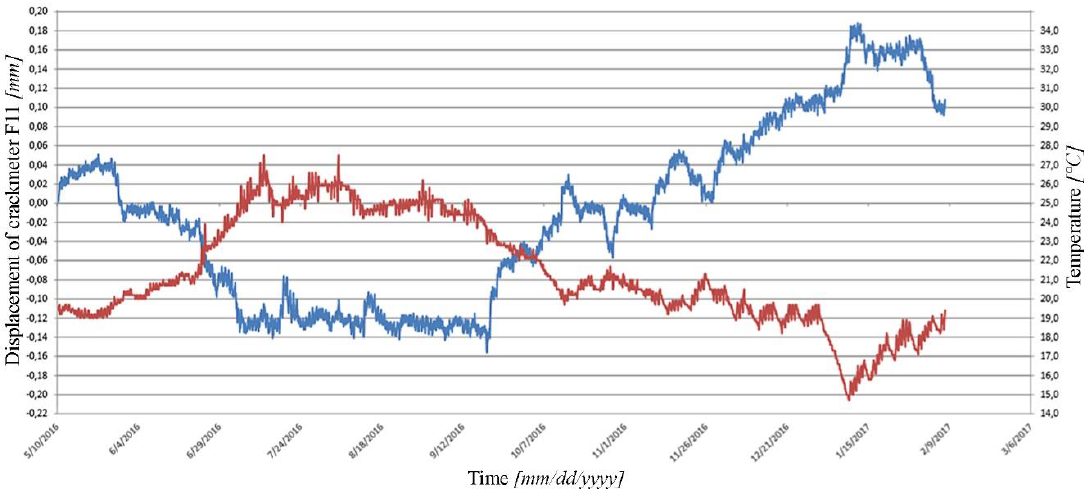
Figure 11. Some results of the monitoring systems (the location of the instruments is shown in Figure 3). The recordings of the crack-meter F11 are marked in red in relation to that of the thermo- pale blue: displacement (-) stands for crack’s closure; displacement ( + ) coincides with an opening of hygrometer in pale blue: displacement (-) stands for crack’s closure; displacement (+) coincides with the an opening of the cracks.